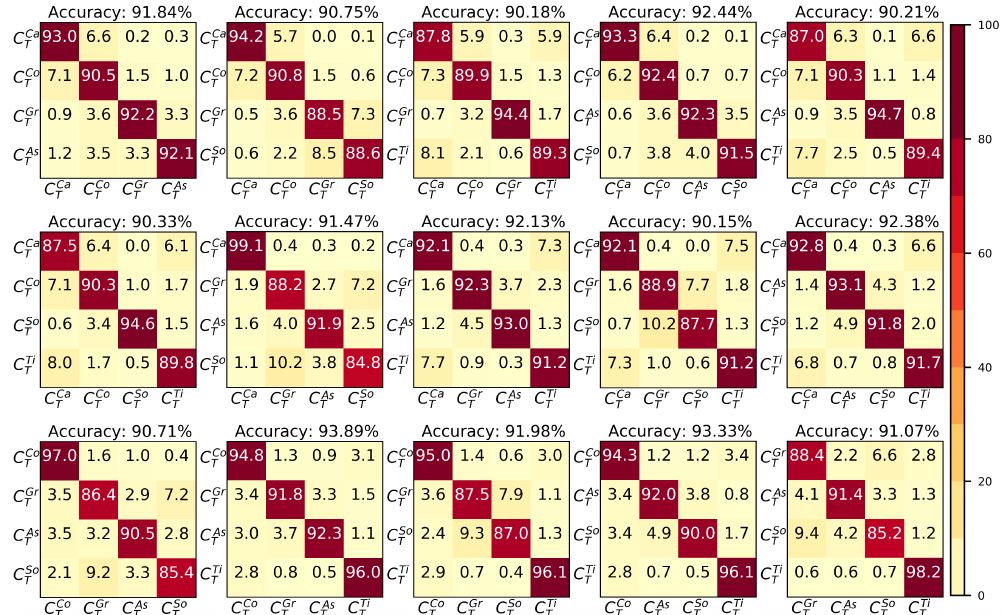
Figure A4. Confusion matrices of quaternary classification with lower back sensor. All results were obtained with all features set (194 features) using SVM classifier. Classes: C Ca = grass , C As = Asphalt , C So = soil , and C Ti = tiles C Gr T T T T